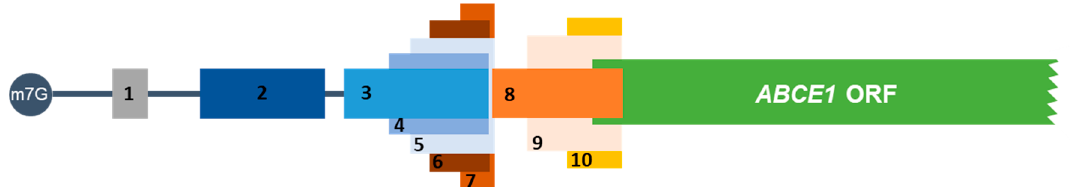
Figure 1. The human ABCE1 5 ′ -leader sequence contains five AUG and five non-AUG uORFs. Schematic representation of the five AUG and five non-AUG uORFs in the 5 ′ -leader sequence of the human ABCE1 mRNA.